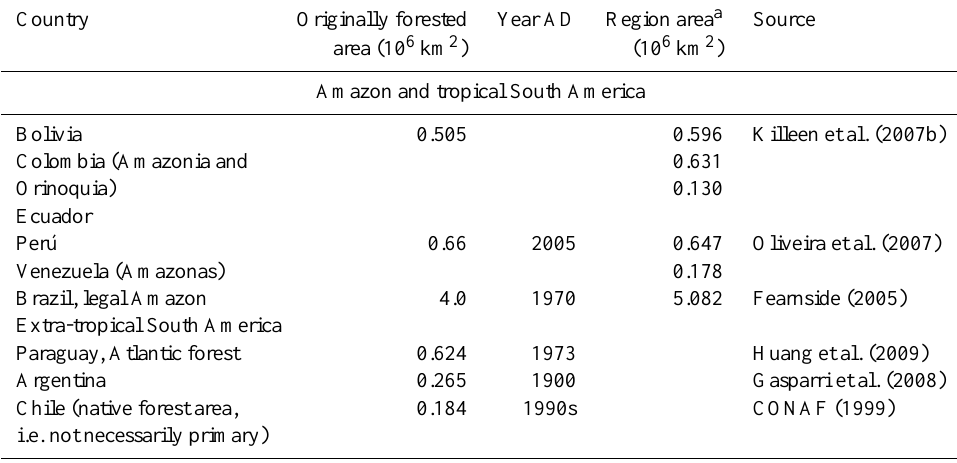
Table 4. Estimates of forested area before the onset of intense deforestation in the 20th century.